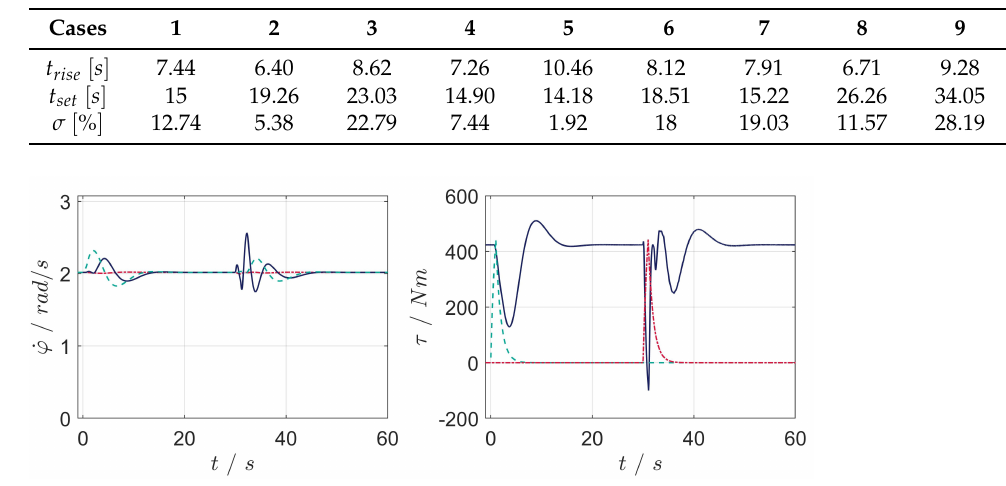
Figure 13. Transient responses of the closed-loop system. Disturbance rejection: ˙ ϕ 0 (solid blue), ˙ ϕ L (dashed green) and ˜ y (dash-dot red). Impulse torques are applied to the second mass at time t 1 = 0 s (dashed green) and to the first mass t 1 = 30 s (dash-dot red).